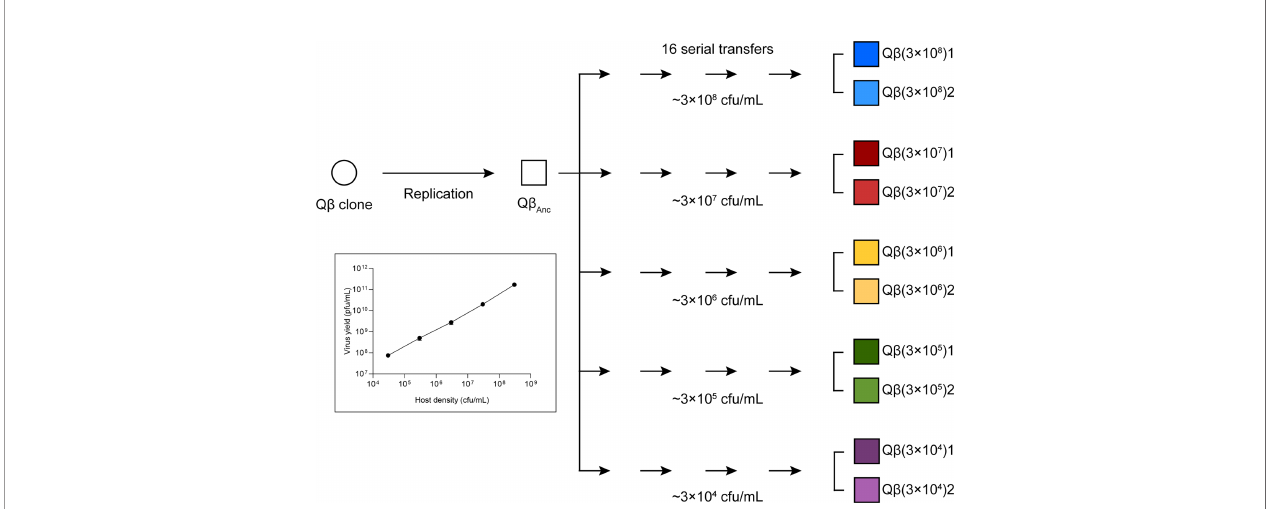
FIGURE 1 | Scheme of the evolution experiment. A lytic plaque obtained upon expression of the plasmid pBRT7Q b was allowed to replicate for 2 h in E. coli Hfr under standard conditions. The population obtained (Q b Anc ) was propagated through serial transfers carried out at different bacterial densities (see Materials and Methods). Evolutionary lineages are represented in different colors and named according to the bacterial density assayed. All lineages were replicated and the replicas distinguished with the numbers 1 and 2. The inset represents an experiment in which the bacteria concentrations indicated in the x axis were infected with 10 7 pfu and incubated for 2 h under standard conditions (see Material and Methods). Supernatants were collected, treated with chloroform and titrated to determine the virus yield. All bacterial concentrations were assayed in